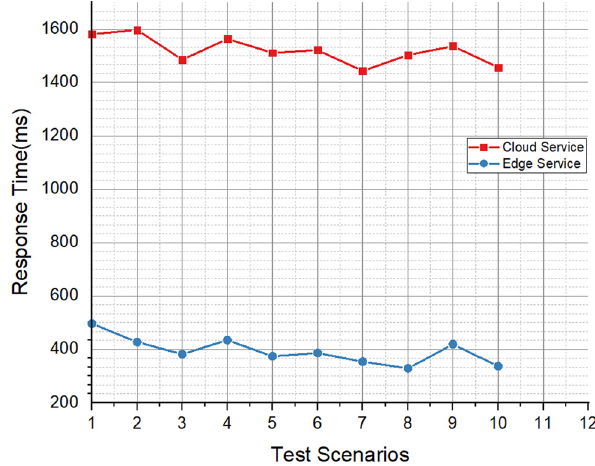
Figure 7: Average response time with 10 test scenarios.